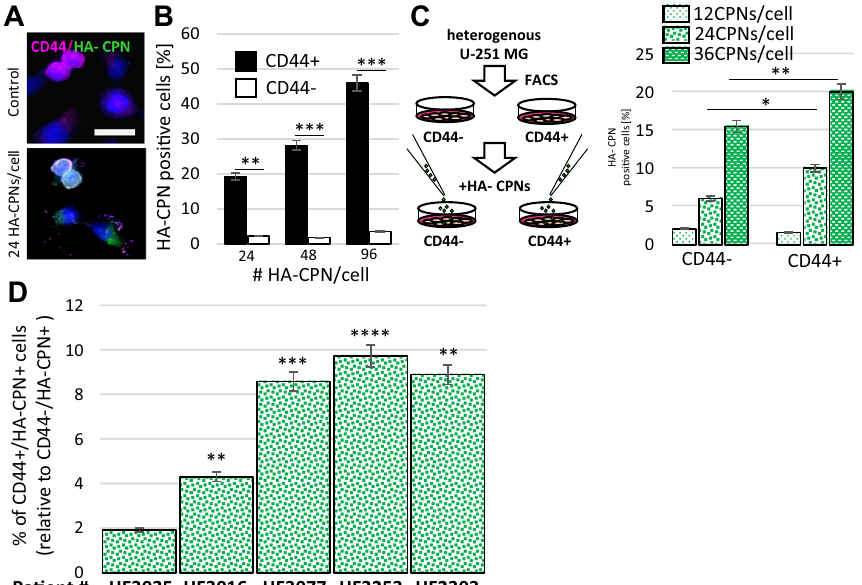
Figure 2. HA-CPNs Demonstrate Selective Uptake by CD44 Enriched U-251 MG Cells as well as GBM Patient- derived Cells. ( A ) Representative image of cells stained with anti-CD44 antibody and treated with 24 HA-CPNs/ cell or vehicle control (Control); scale bar: 25 μm; ( B ) Flowcytometry analysis of U-251 MG cells stained with anti-CD44 antibody and treated with 24, 48, 96 HA-CPNs/cell or vehicle control (Control). Cells positive for HA-CPNs graphed as % of cells positive (CD44 +) and/or negative (CD44-) for the antibody stain; ( C ) Flowcytometry analysis of HA- CPN positive U-251 MG cells in FACS- derived CD44 + and CD44- populations treated with 12, 24, 36 HA-CPNs/cell graphed as % of the population tested; ( D ) GBM patient- derived cultures (HF3035, HF3016, HF3077, HF3253, HF2303) tested for CD44-selective HA-CPN uptake and quantified as % of CD44 + cells relative to the % uptake in CD44- cells. Data shown as mean ± s.d, n = 3, *p < 0.05, **p < 0.01, ***p < 0.001; Student’s t